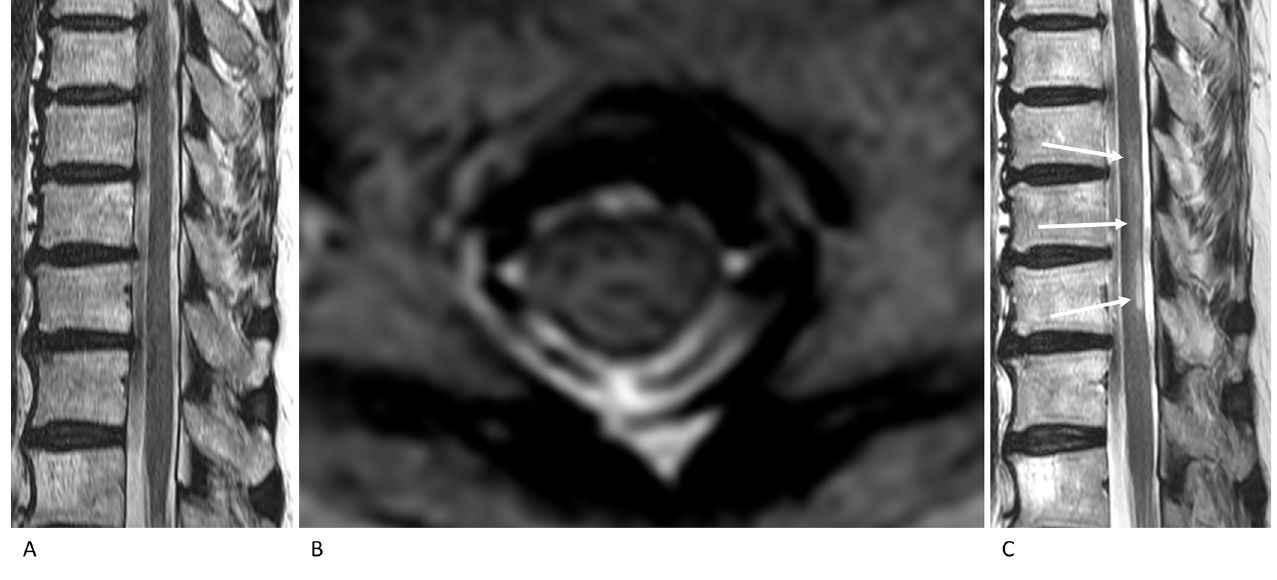
Fig 3. T2-weighted MRI of the lower thoracic spine in a patient with spinal cord infarction (80-year-old woman, patient number 9 in Table 4). On sagittal (A) and axial (B) images obtained between 6 and 12 h after symptom onset, changes in the cord signal are not obvious. The authors evaluated the confidence score to be 2. Follow-up MRI (C) performed between 24 and 72 h after symptom onset shows distinct hyperintensity in the dorsal spinal cord (arrows). The authors evaluated the confidence score to be 4.